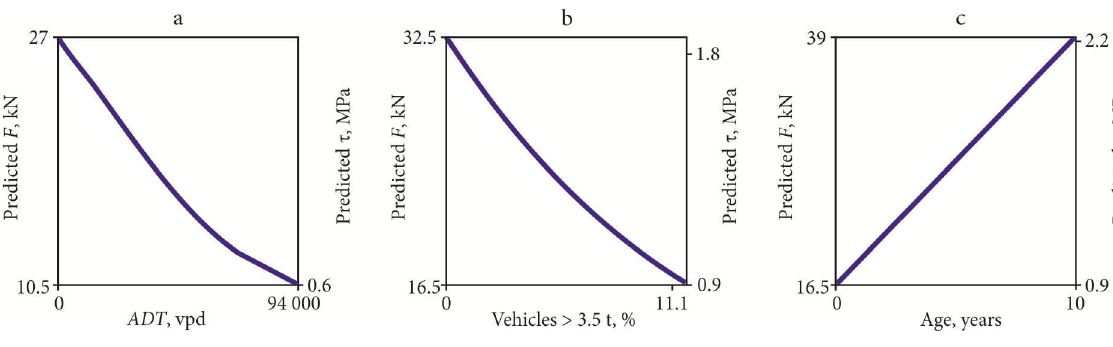
Fig. 11. Response graphs of the input variables as a function of F max and τ max : a – ADT ; b – vehicles > 3.5 t; c –